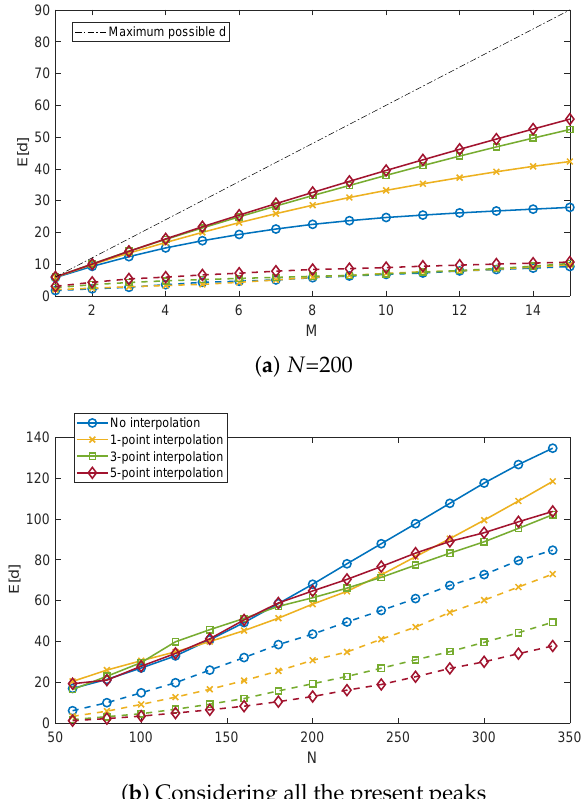
Figure 11. E [ d ] for different values M of selected peaks ( a ) and N of the key length ( b ). Solid and dashed lines refer to the Alice-Eveand Alice-Bob links,